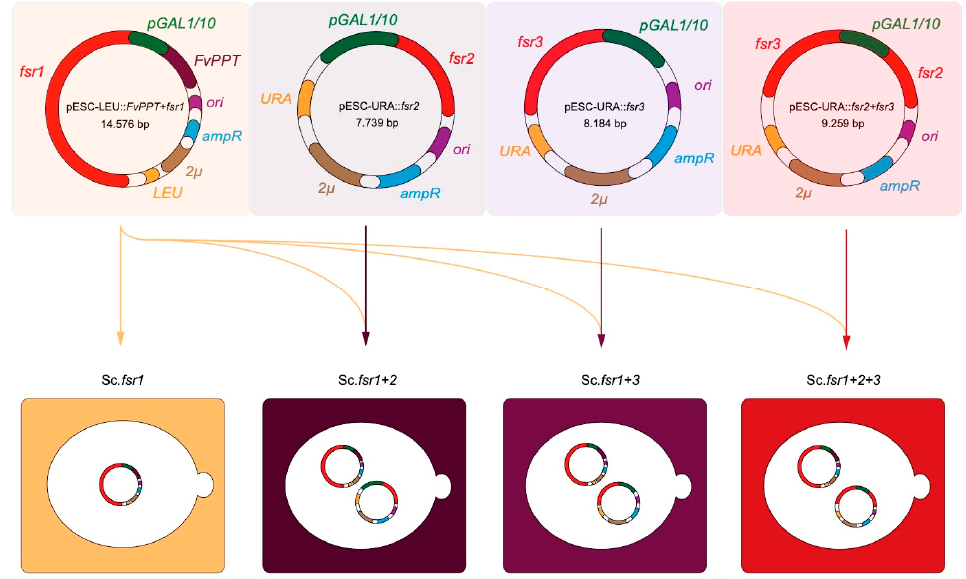
Figure 5. Final constructs of expression vectors utilizing the URA or LEU auxotrophic selection in S. cerevisiae BY4743, GAL1 / 10 inducible promotor, bacterial ( ori ), yeast ( 2 µ ) origin of replication along with the bacterial selection marker ( amp R ). Sc:: fsr1 contains only the fsr1 -gene, the main biosynthetic gene; a type I non-reducing PKS (NR-PKS) and FvPPT , a 4´-phosphopantetheinyltransferase (PPTase) from Fusarium verticillioides for successful phosphopantetheinylation of the acyl carrier protein (ACP)-domain of fsr1 . The following strains contain a dual vector system. Sc:: fsr1 + 2 contains both FvPPT, fsr1, and the fsr2 -gene, a O-methyltransferase. Sc:: fsr1 + 3 contains FvPPT, fsr1, and the fsr3- gene encoding a monooxygenase. Finally, Sc:: fsr1 + 2 + 3 contains all core biosynthetic genes involved in the synthesis and tailoring, FvPPT , fsr1, fsr2, and fsr3 .